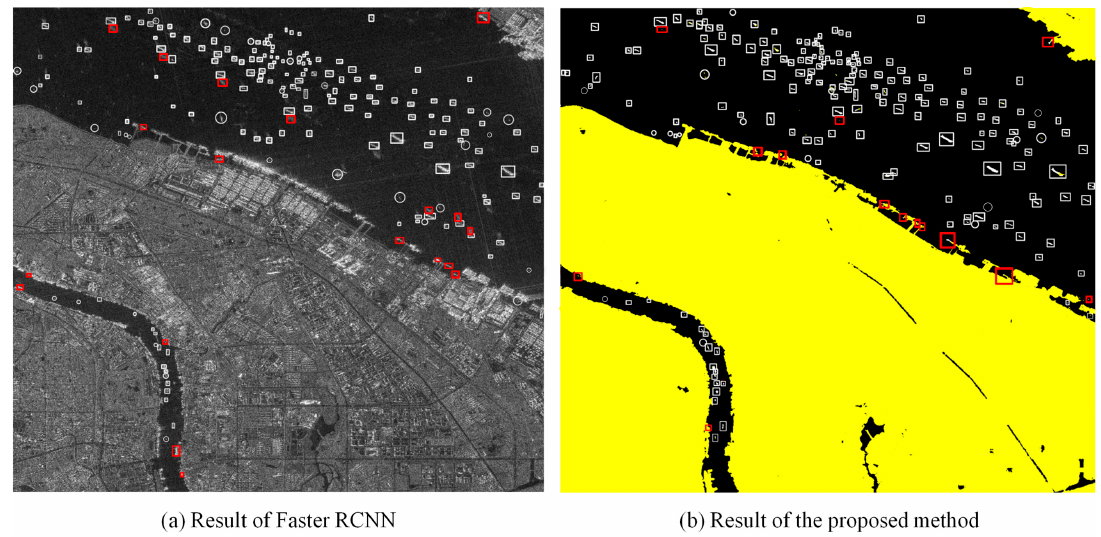
Figure 8. The comparison of the results between Faster region-based convolutional neural network (RCNN) and the proposed method. The white and red rectangles represent the detected targets and false alarms respectively, and the white circles represent the missed targets.